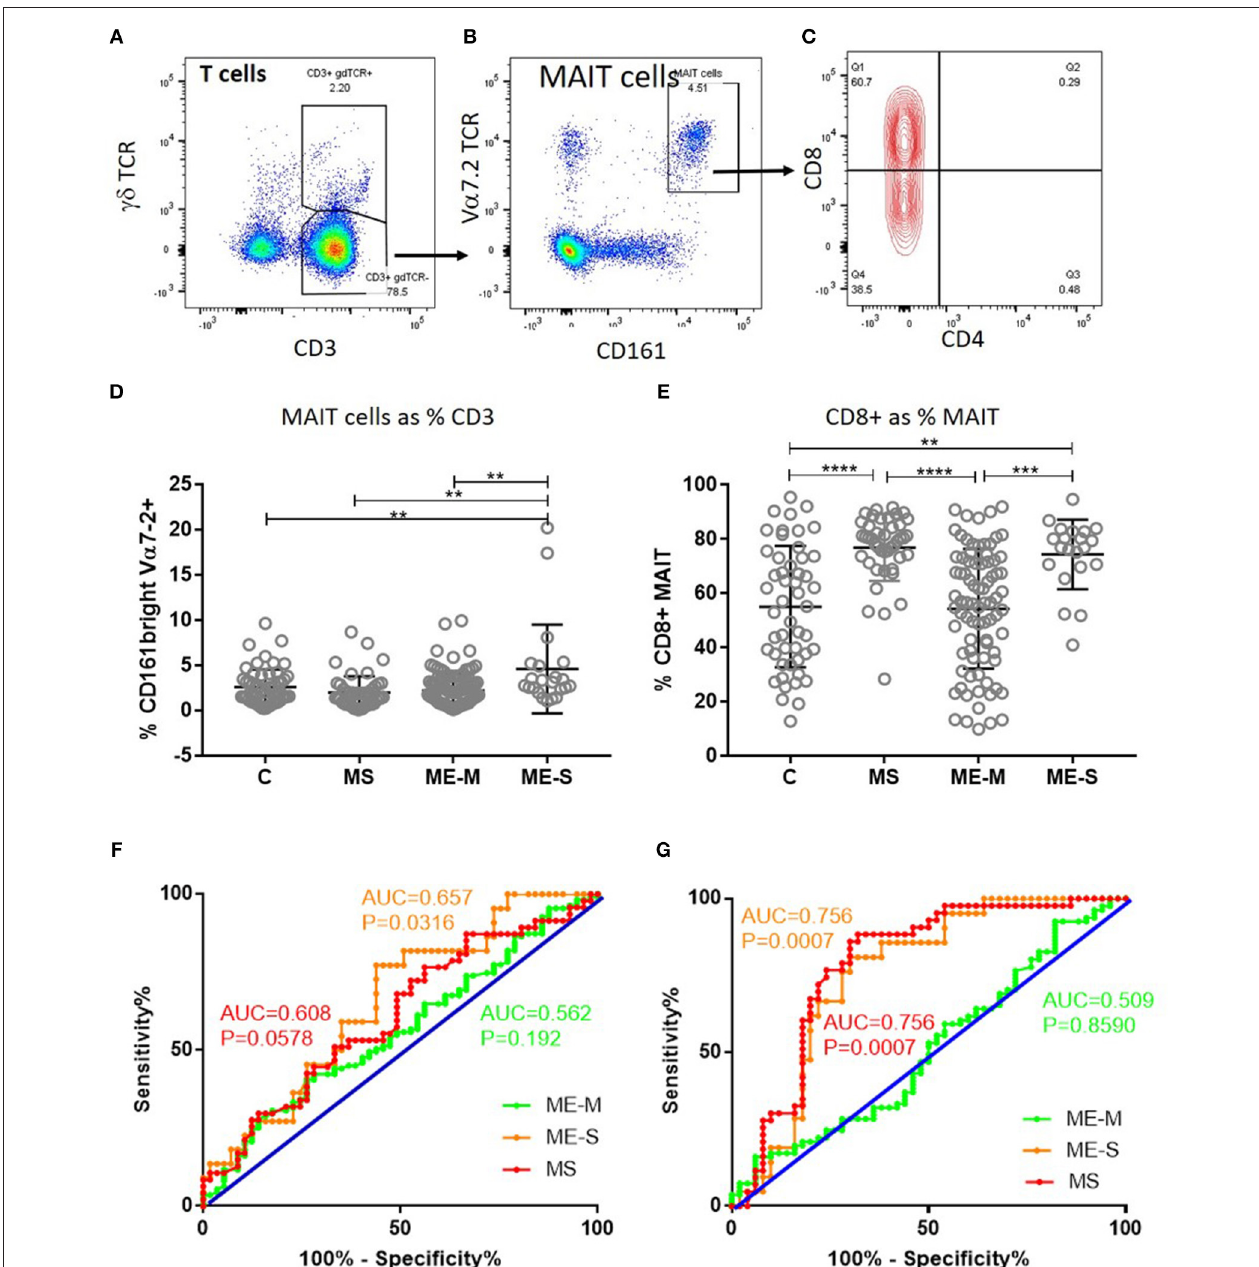
FIGURE 6 | Mucosal Associated Invariant T cells in peripheral blood of people with ME/CFS, people with MS and healthy controls. By flow cytometry, within the CD3 + γδ TCR − T cell population (A) , MAIT cells were identified as V α 7.2 + CD161 ++ in PBMC (B) . MAIT cells were further characterised based on CD4 + or CD8 + expression (C) . (D) The proportion of T cells which were MAIT cells in PBMC from mild-moderate ME/CFS (ME-M), severely affected ME/CFS (ME-S), multiple sclerosis (MS), and healthy controls (C) is shown. (E) The proportion of MAIT cells which were CD8 + is shown for each individual. (A–C) Data from one representative severely affected ME/CFS patient. (D,E) Data are from C ( n = 56), MS ( n = 46), ME-M ( n = 120), and ME-S ( n = 21). Clinical groups were compared by Kruskal-Wallis test for non-parametric data: ** P < 0.01, *** P < 0.001, **** P < 0.0001. (F) ROC curve analysis of proportions of the CD3 + γδ TCR − T cell population which were MAIT cells for the different patient groups relative to the Healthy Controls. (G) ROC curve analysis of proportions of MAIT cells which were CD8 + for the different patient groups relative to the Healthy Controls. AUC, Area Under the Curve.